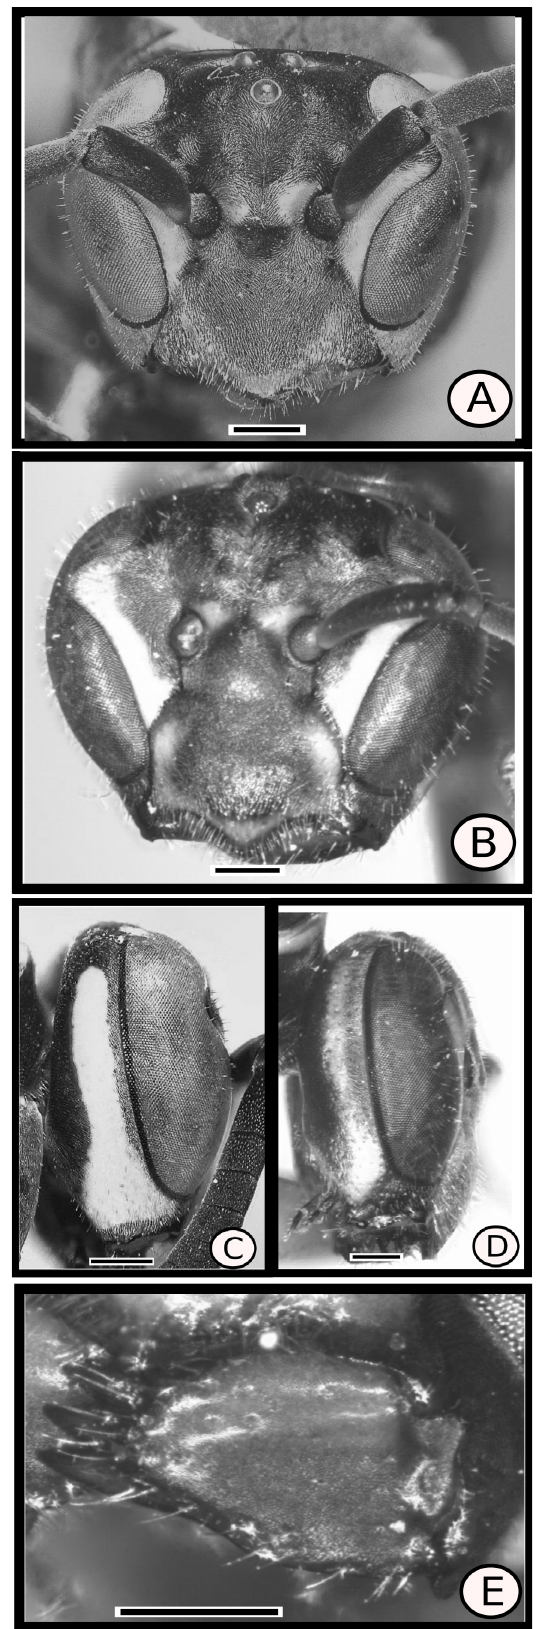
Fig 3 . A, C and E: head in frontal view, head in lateral view and mandible in frontal view of Chartergellus trinitatis, respectively; B and D: head in frontal view, head in lateral view of Chartergellus afoveatus, respectively . Scale bar = 0.5 mm.